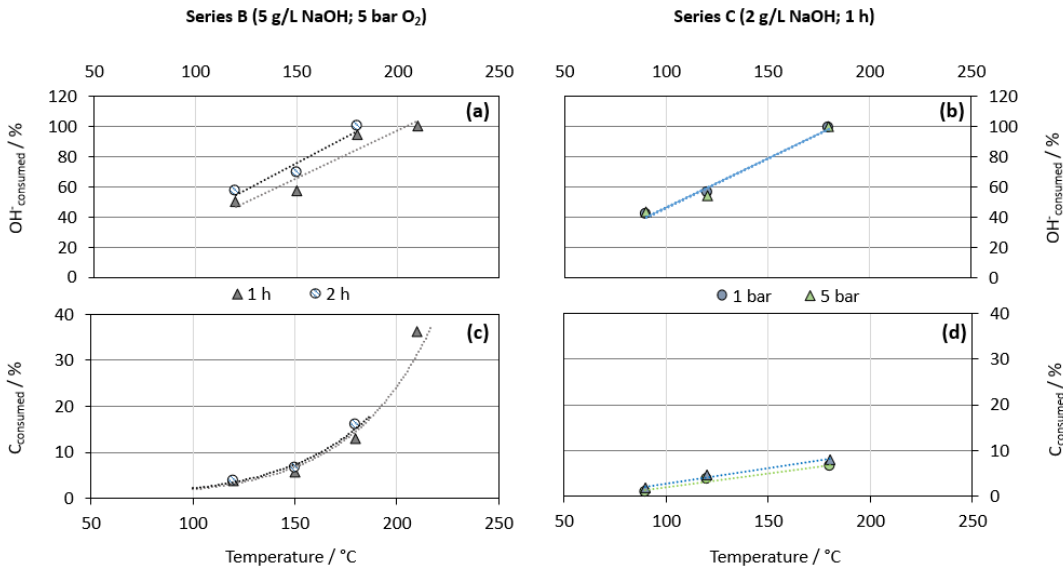
Figure 14. The OH − consumption in series B ( a ) and C ( b ); the residual carbon in series B ( c ) and C ( d